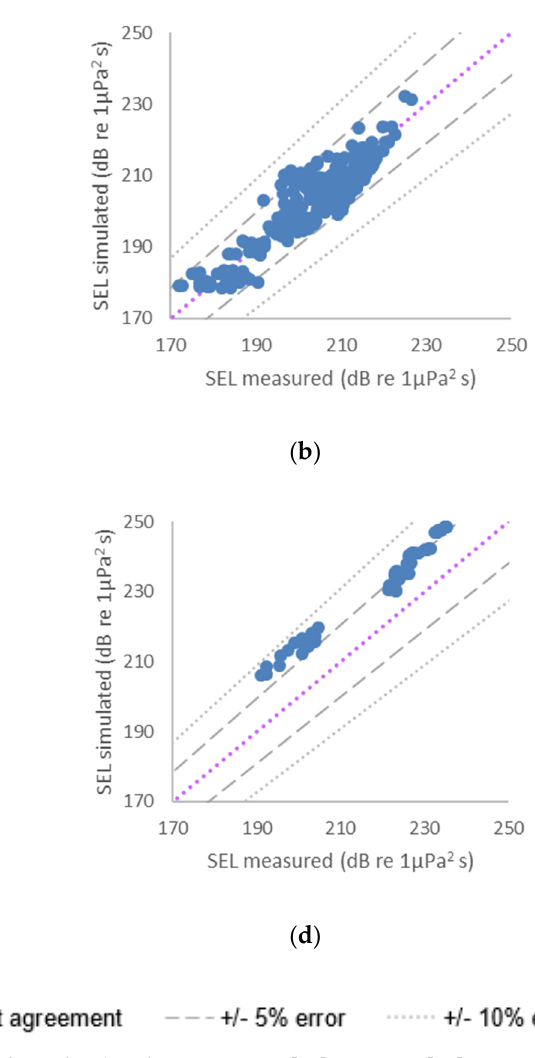
Figure 2. Comparison of simulated against measured values of SEL for data from: TAP-025 [53], TAP-118 [52]; TAP-570 [51] and BOEM 2016-019 [50]. ( a ) Conductors (BML) (not TAP-570); ( b ) piles (not TAP-025); ( c ) conductors and piles; and from TAP-025 and TAP-570, ( d ) open water (before model adjustment).